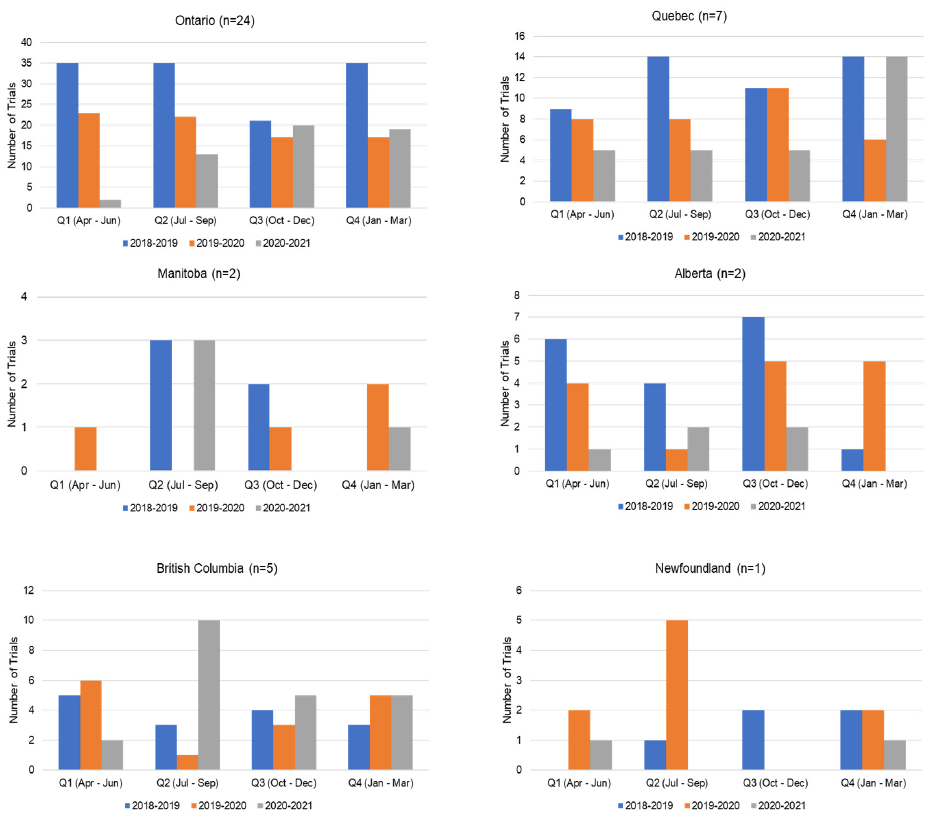
Figure A2. 3CTN Portfolio trial site activations at adult cancer centers by province from 1 April 2018–31 March